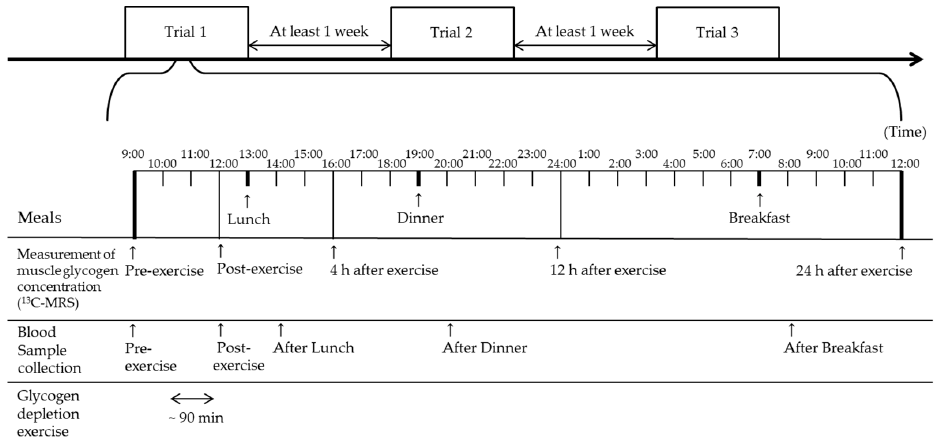
Figure 1. Experimental design of the study.